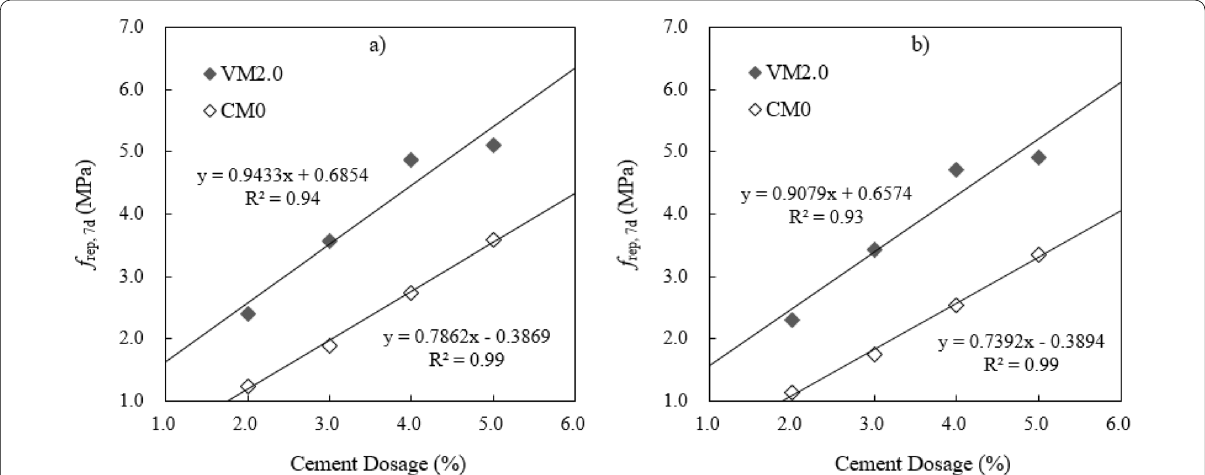
Fig. 7 7-Day UCS versus cement dosage under different highway grades: a for the second-class highway and under (JTG/T F20-2015 2015); b for expressway and the first-class highway (JTG/T F20-2015